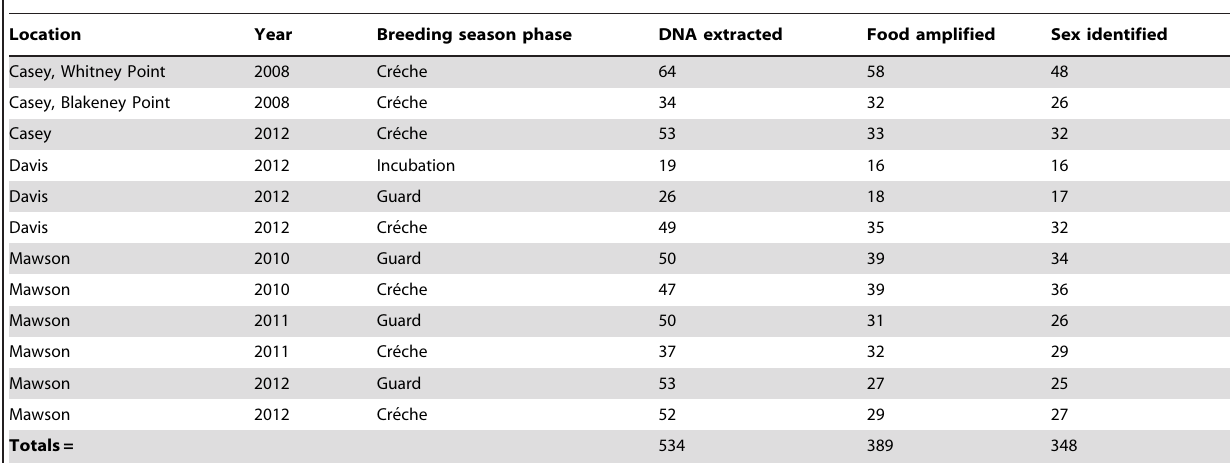
Table 1. Samples used in this